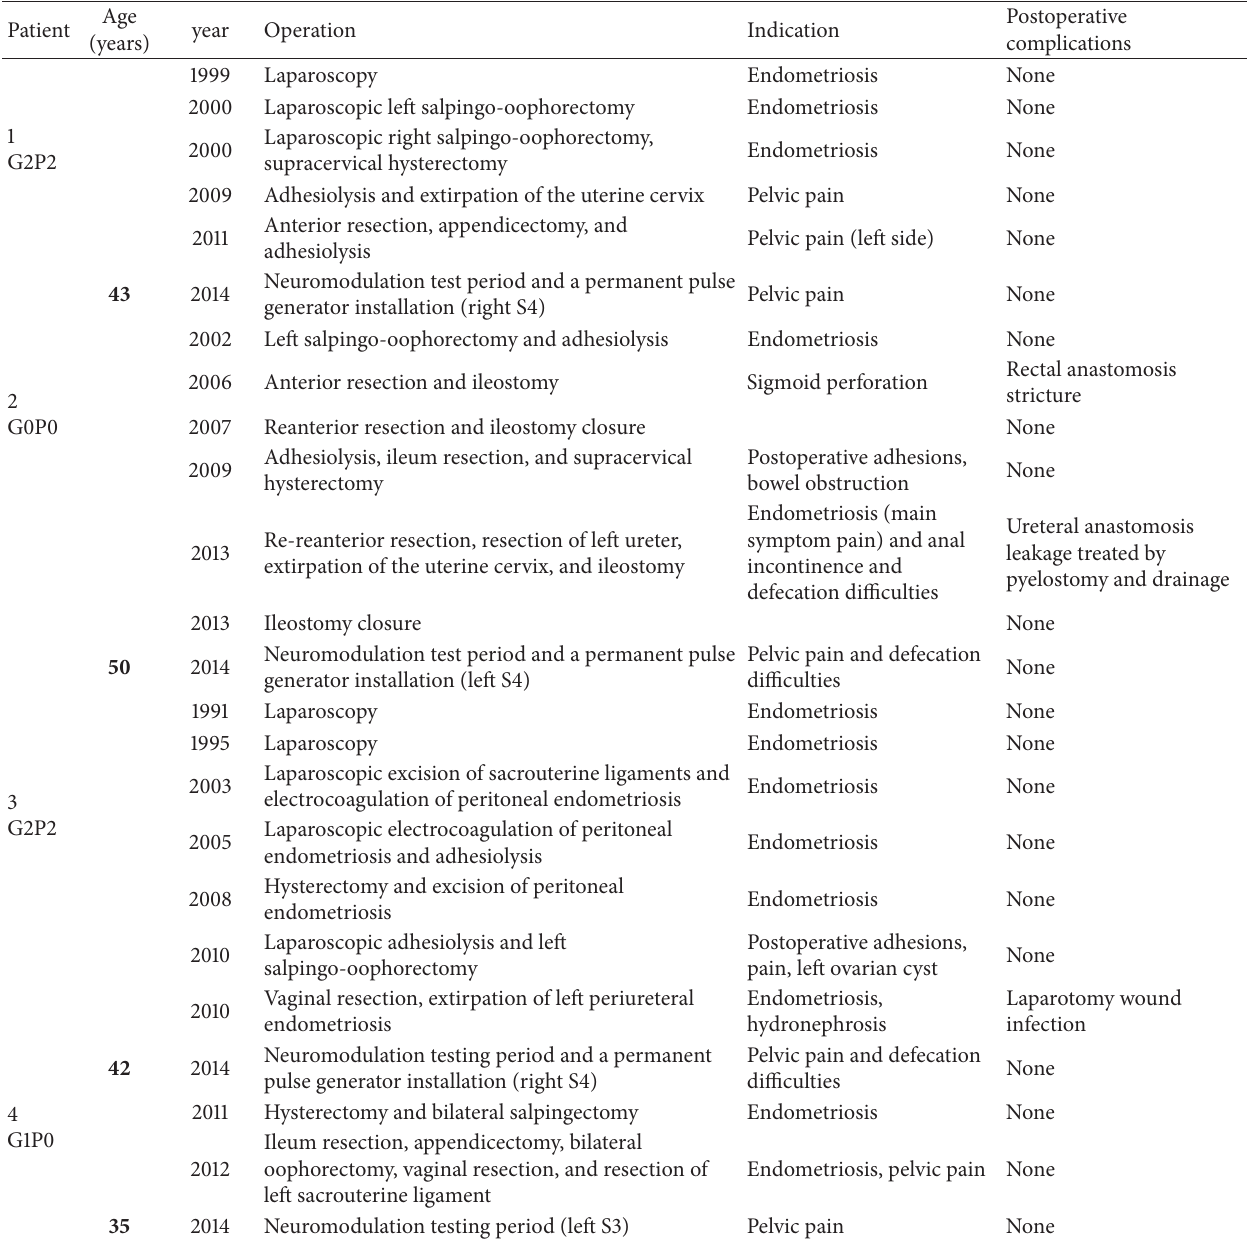
Table 1: Surgical history of the four women in the neuromodulation pilot study. Operations were performed by laparotomy if laparoscopy is not mentioned in the